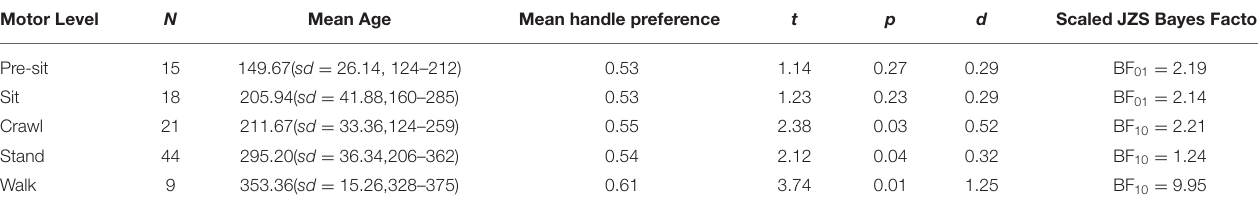
TABLE 1 | Mean handle preference and age (in days) by Motor Level.